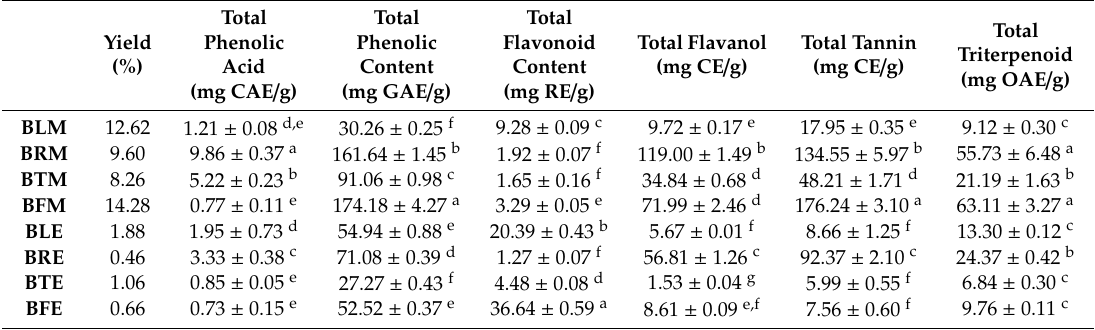
Table 5. Extraction yield (%) and total bioactive compounds of Bruguiera gymnorhiza extracts.